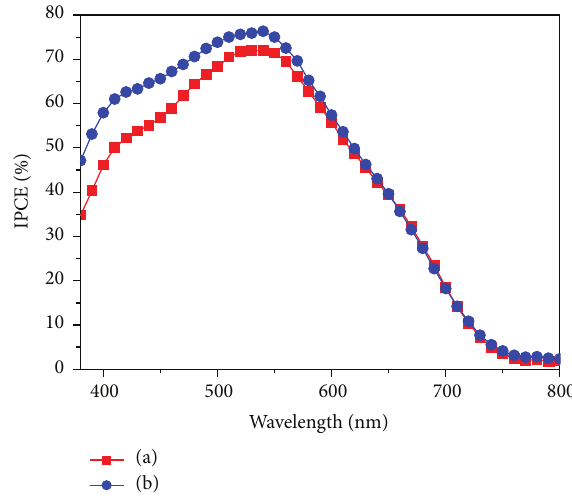
Figure 6: IPCE characteristics of the DSSCs with composite films counter electrode (a) and Pt (b).